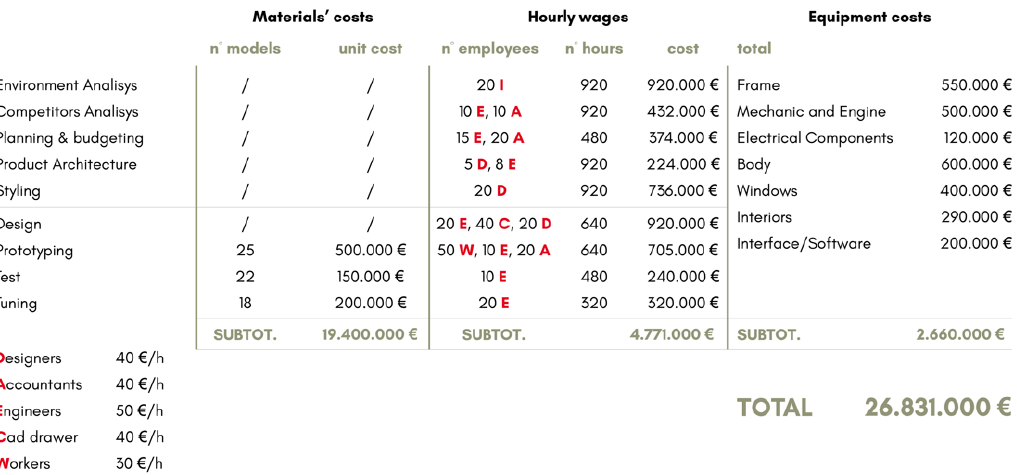
Figure 14. Cost-based Budget Planning.